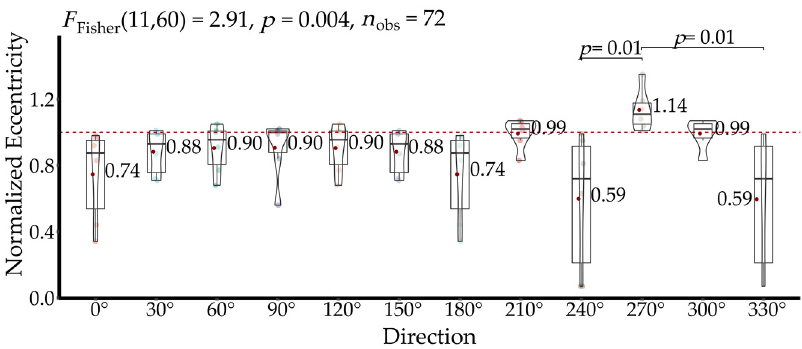
Figure 12. Normalized eccentricities among different impact directions.